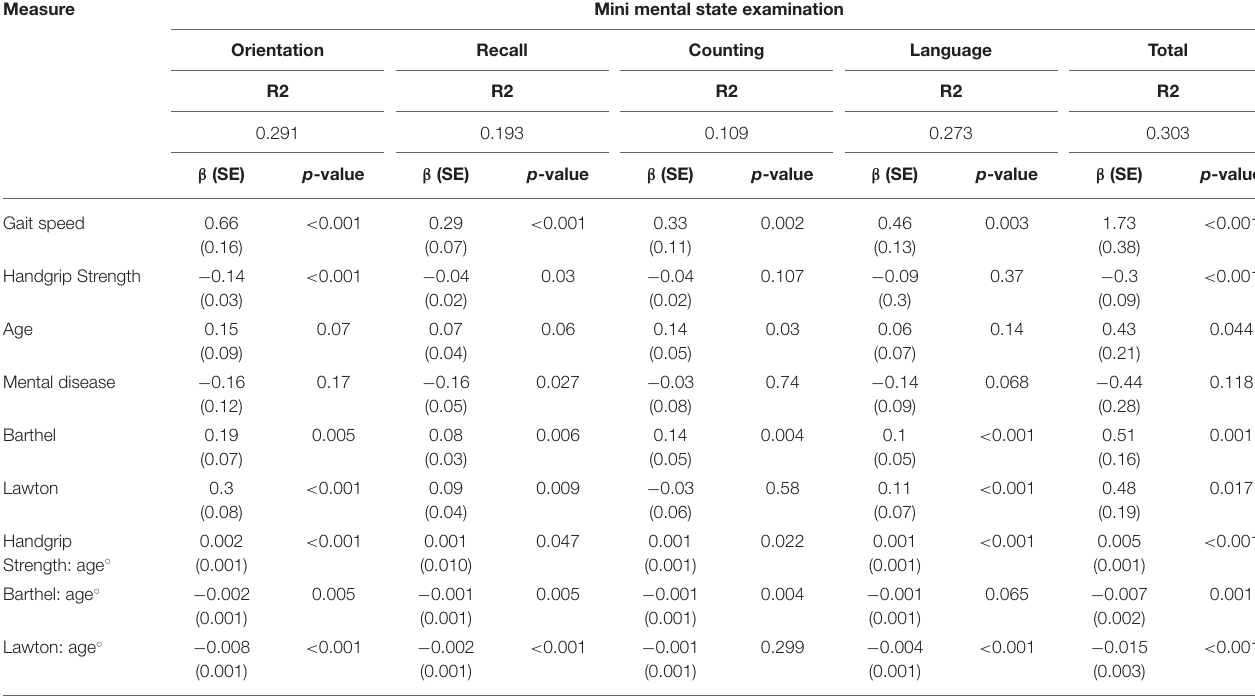
TABLE 3 | Association’s model for cognitive